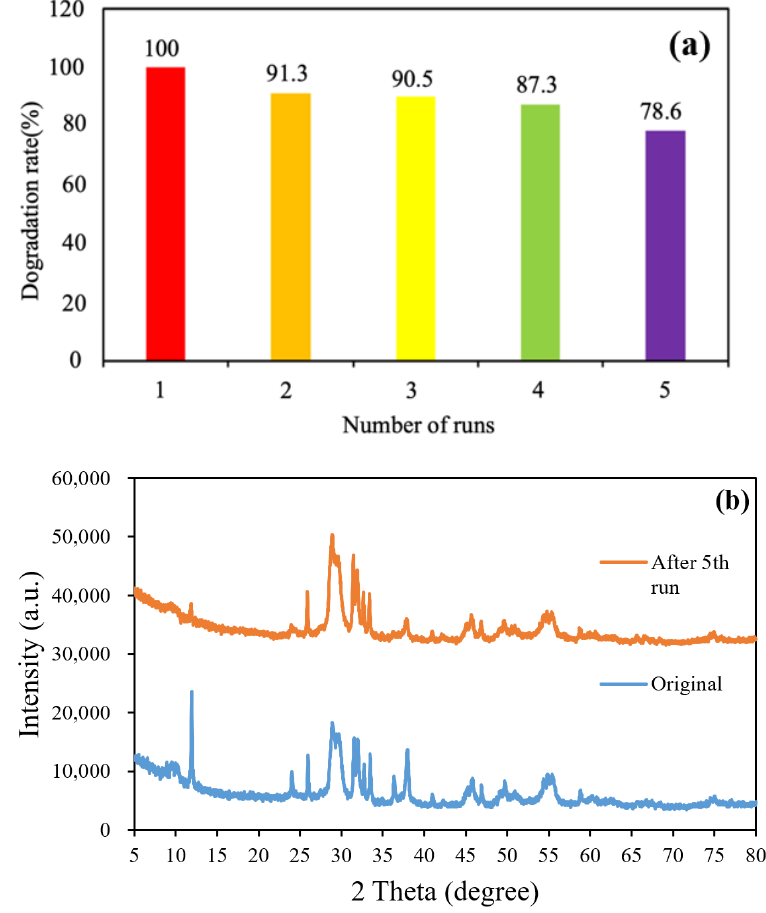
Figure 11. ( a ) Cycling runs in the photocatalytic degradation of CV in the presence of the BiOmCln/BiOpIq/g-C3N4-20% photocatalyst prepared under a KCl:KI molar ratio of 1:2, a hydro- thermal temperature of 250 °C, and a pH of 4. ( b ) XRD patterns of the aforementioned photocatalyst before use and after five times of